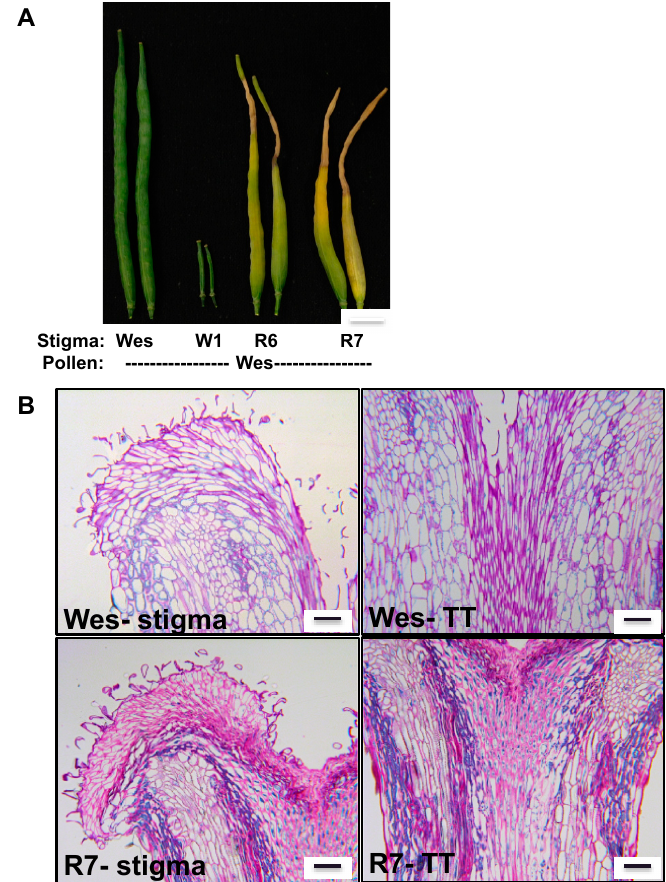
Figure 3. Loss of GLO1 results in increased damaged to the stylar transmitting tract and female reproductive tissue during pod development. ( A ) GLO1 suppressed lines (R6 and R7) showing tissue death phenotype that radiates down from the top of the stigma during pod development following compatible pollination; ( B ) Histological sections of pods of similar age from Wes and R7 line showing increased cell death in the vascular tissue and cells around the stigma and stylar transmitting tract (TT) in the absence of GLO1. Scale bars = 100 μ m.